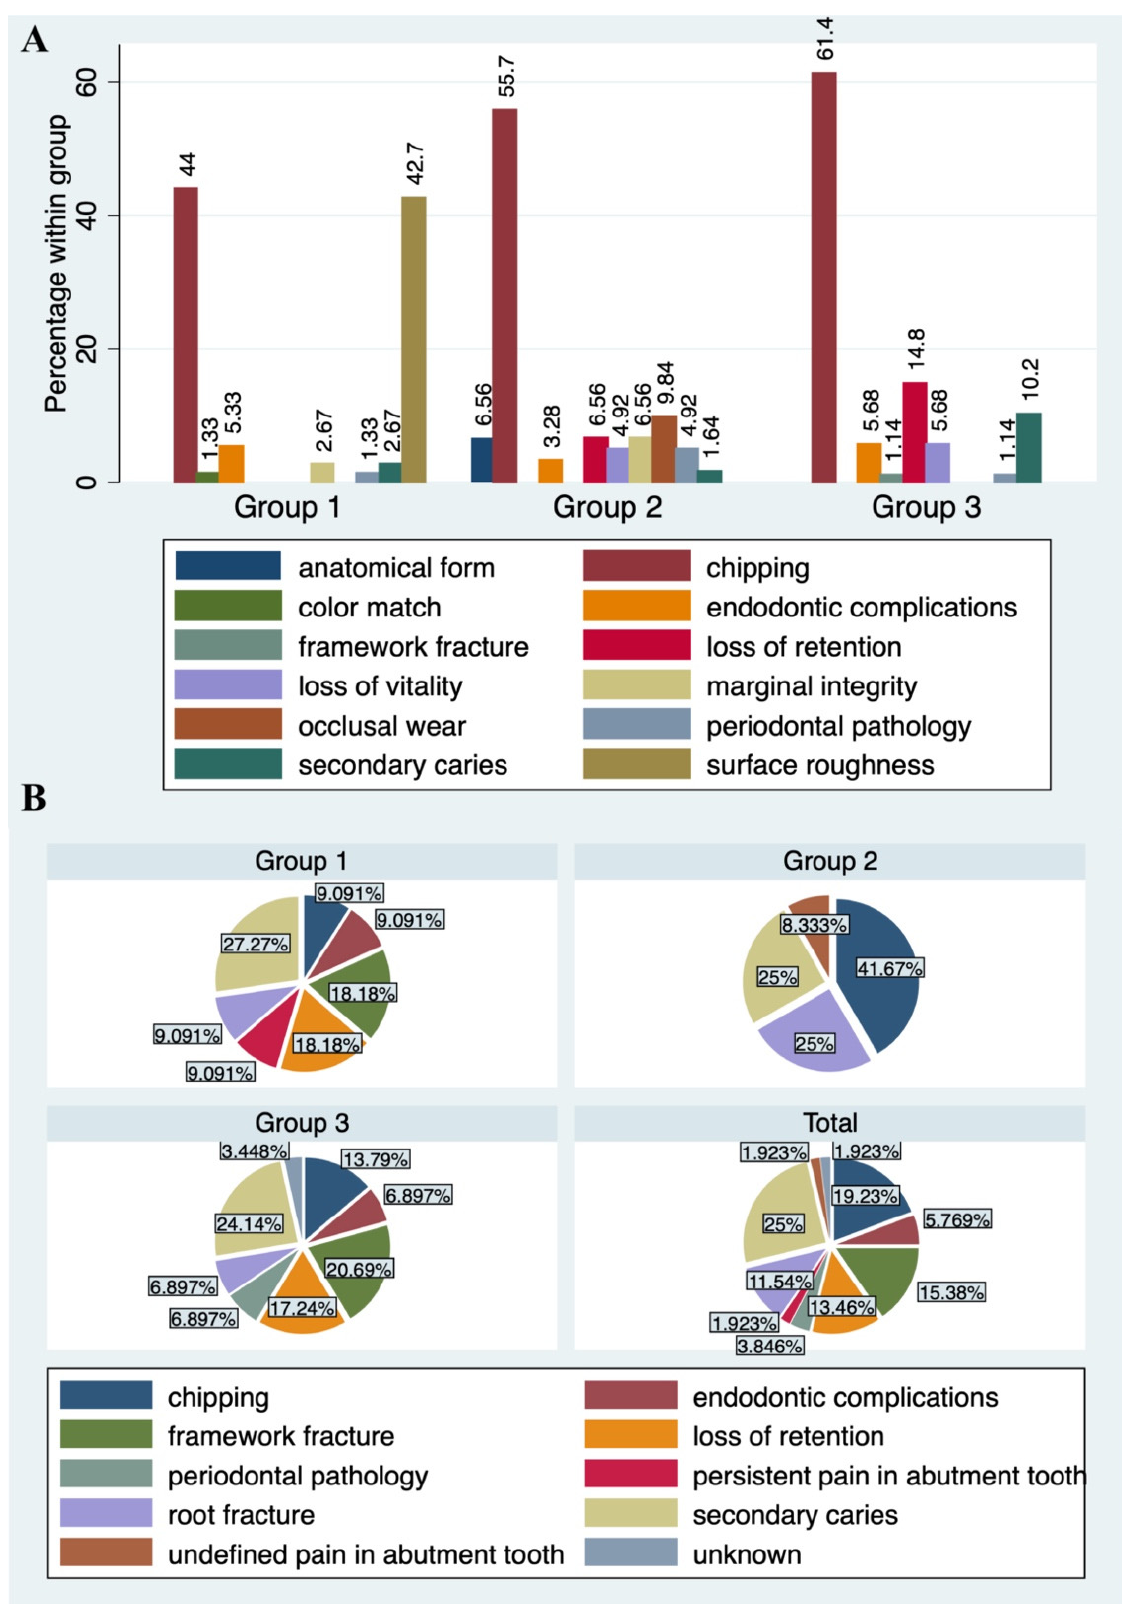
Figure 3. Distribution of complications ( A ) and failures ( B ) stratified by follow-up time frames. Group 1: follow-up from 18 to 46 months; Group 2: follow-up from 60 to 84 months; Group 3: follow-up from 116.4 to 120 months.